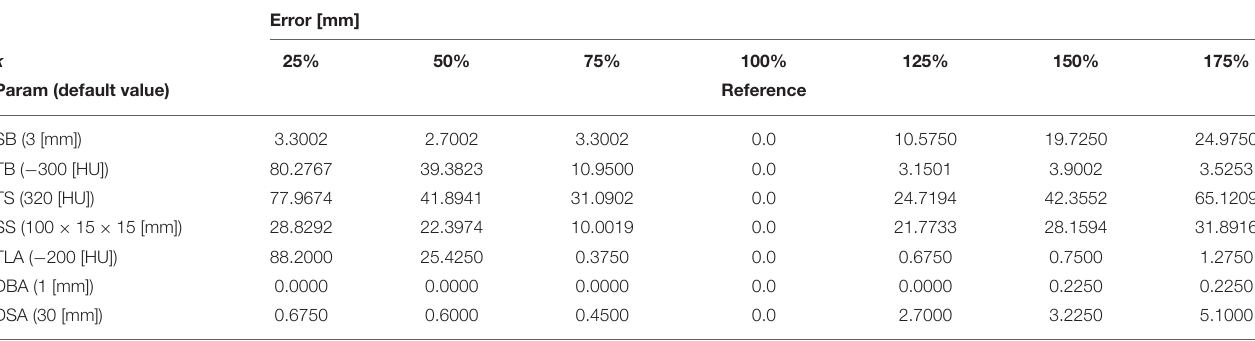
TABLE 3 | Sensitivity of the parameters for the positional features algorithm measured by relative displacement of the origin of the coordinate system: k is the default parameter value